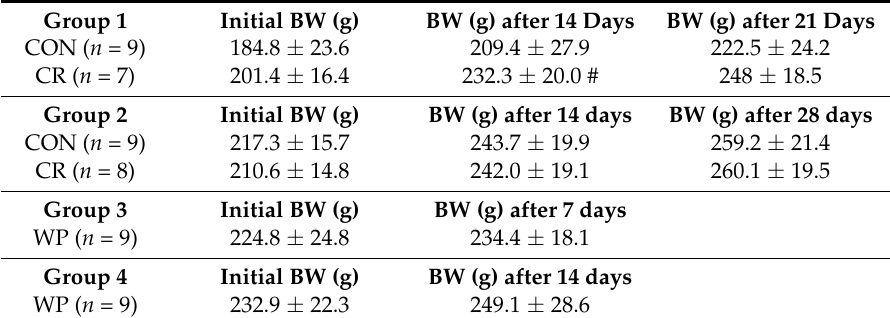
Table 1. The effect of standard rat chow diet (CON), creatine (CR), and whey protein (WP) supplementation on animal body weights (BW)